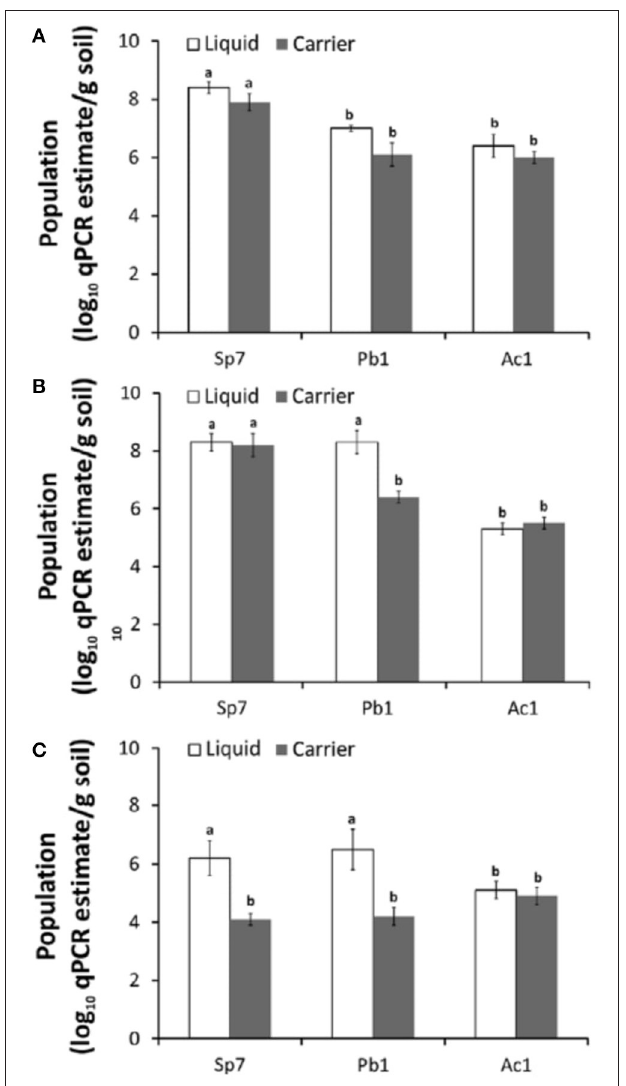
FIGURE 2 | PCR targeting SCAR markers of biofertilizer strains for strain-level authentication and qualification in maize rhizosphere at different growth stages 15th (A) , 30th (B) , and 60th (C) day. Error bar indicates with letters “a” and “b” (ANOVA and DMRT test; p < 0.05) (Reddypriya et al., 2019) Reproduced with